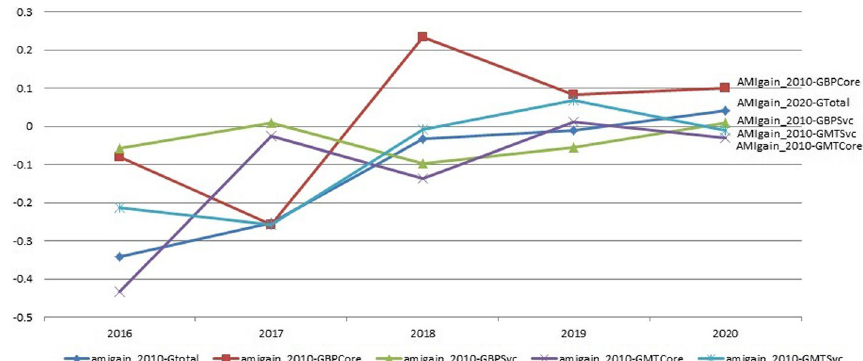
Fig. 2 Correlations between AMI gain (from 2010 to 2014) and annual firm numbers and growths by